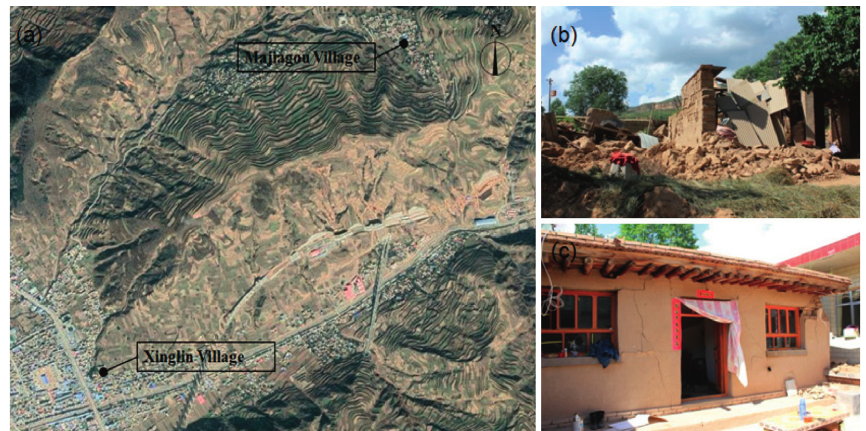
Figure 2: Differences in earthquake damage in two typical villages. (a) Topography of the two typical villages, (b) house damage in Majiagou village, and (c) house damage in Xinglin